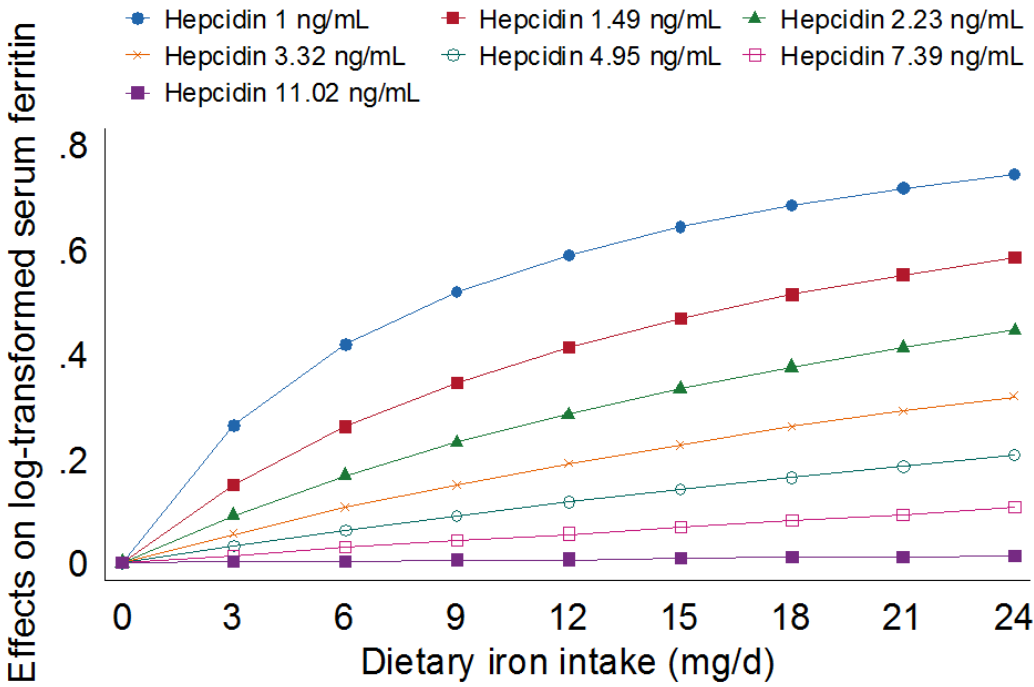
a All models adjusted for natural log ‐ transformed C ‐ reactive protein. b Natural log ‐ transformed independent variable.